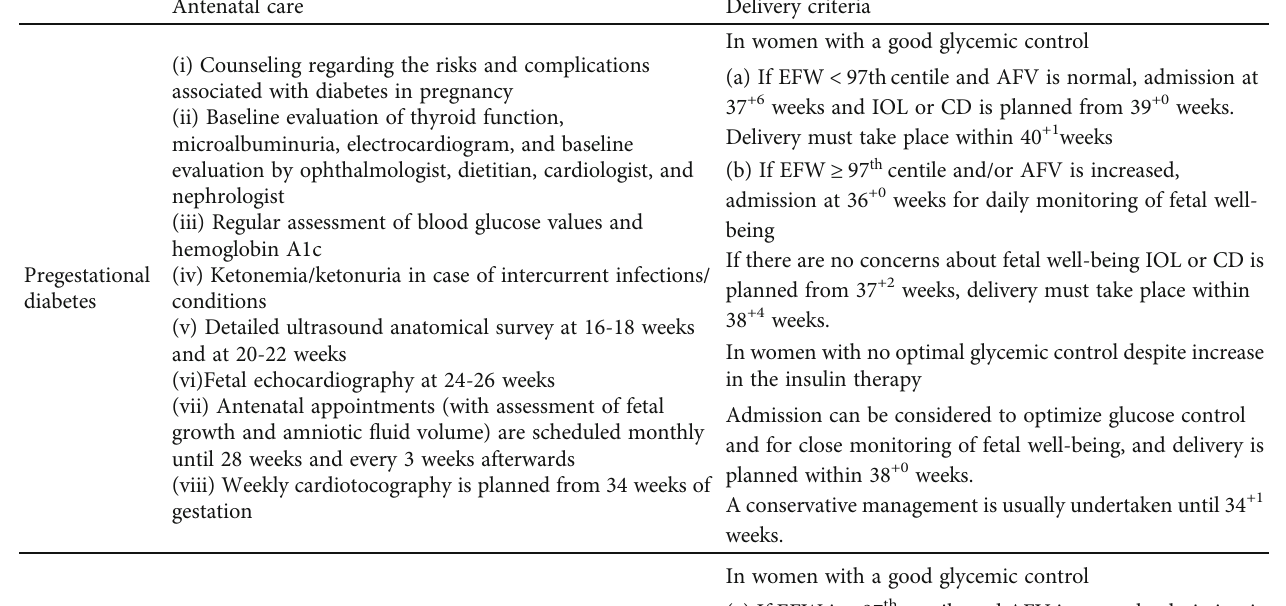
Table 1: The standardized multidisciplinary management protocol